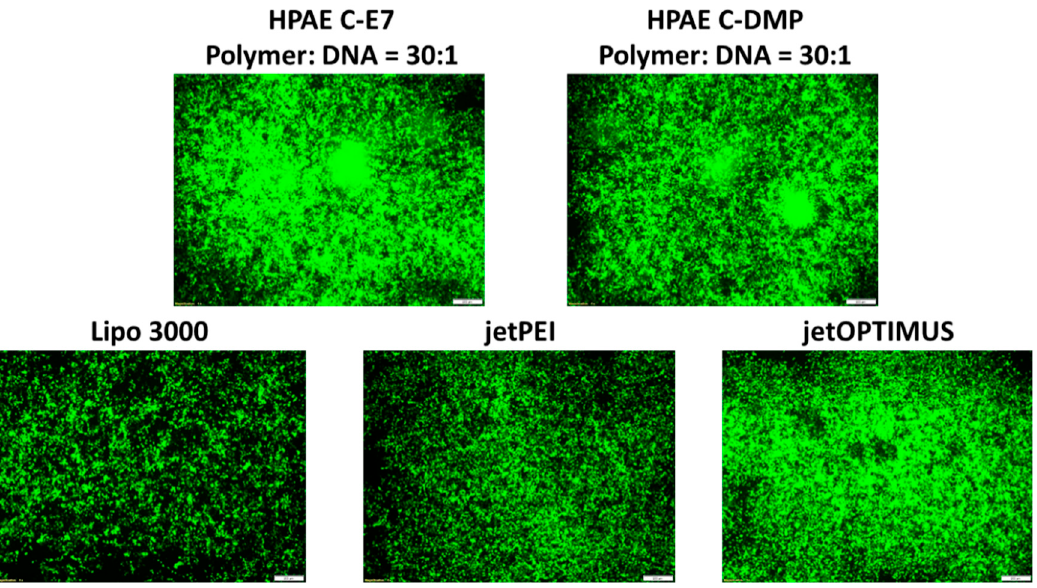
Figure 5. Microscopic images of HEK293 cells 48 h post-transfection . HPAE C-E7 and C-DMP ex- hibited much better transfection performance than popular commercial transfection agents (Lipo3000, jetPEI, and jetOPTIMUS). The scale bars present 100 µm.